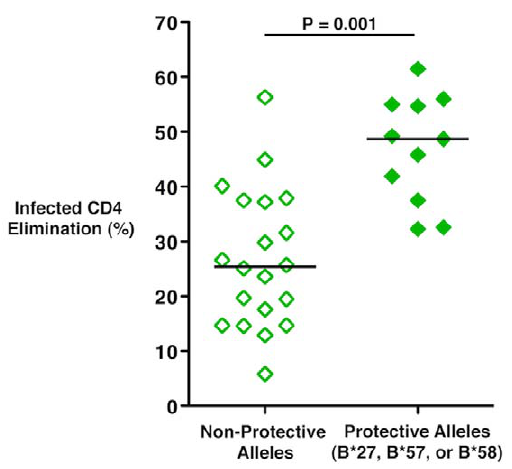
Figure 5. HIV-specific CD8 + T-cell cytotoxic capacity in Ad5/HIV vaccine recipients was higher among individuals with protec- tive HLA class I alleles. ICE responses mediated by day 6 CD8 + T-cells of vaccine recipients who possess the HLA class I alleles B*27, B*57 or B*58 that have been shown to be associated with nonprogressive HIV infection (n=11) versus those of vaccine recipients not possessing these protective alleles (n=20) was compared by the Wilcoxon two- sample test. Horizontal lines represent median values. Data are representative of at least two experiments.